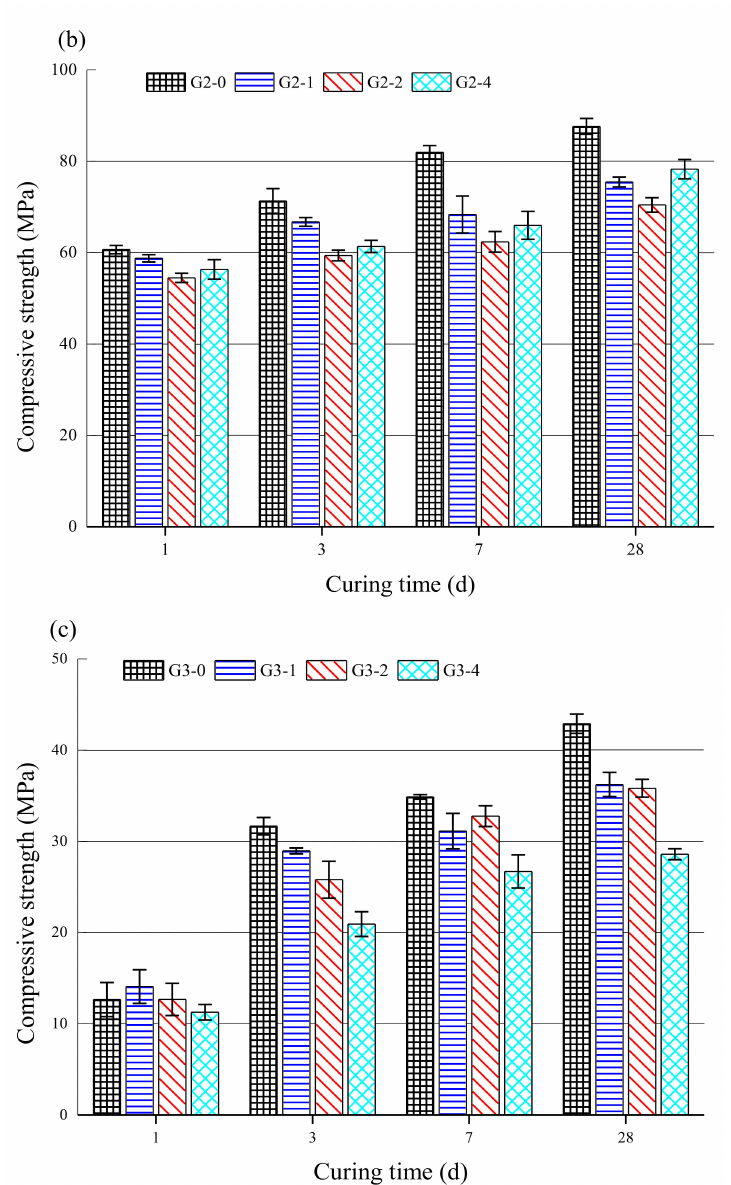
Figure 4. Compressive strength of the MKPC specimens with various glass powder contents (0, 10, 20, and 40 wt.%) and M/P ratios of ( a ) 1:1, ( b ) 2:1, and ( c )